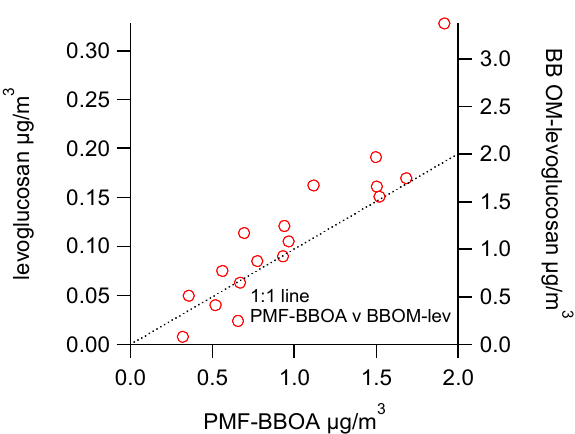
Figure 5. Percentage of OM apportioned by four methods for each time period where levoglucosan was quantified; boxes indicate nighttime averages (1700–0500 LST). Not shown is K-BBOA value of 100% apportioned OM on 17 January 1700-0500.